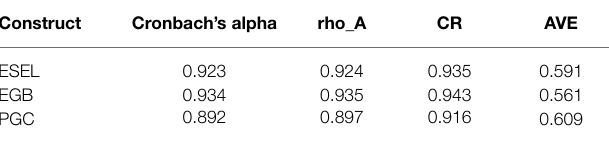
TABLE 3 | Validity and reliability.